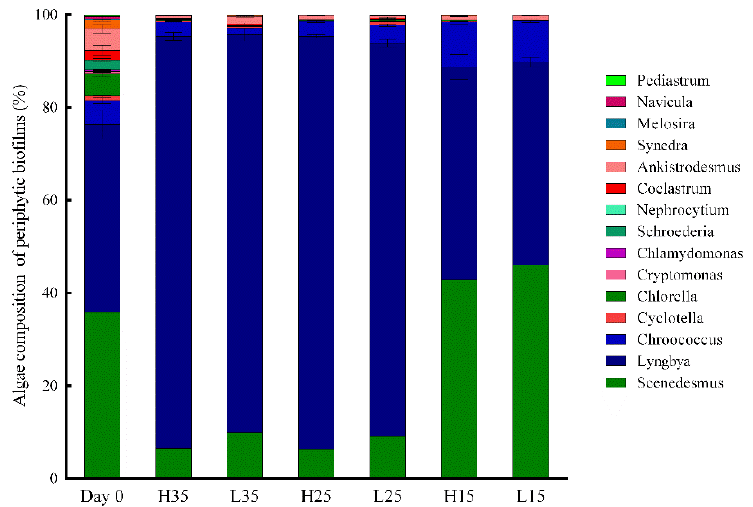
Figure 4. Algae composition of the periphyton on day 0 and day 12 in different treatments.